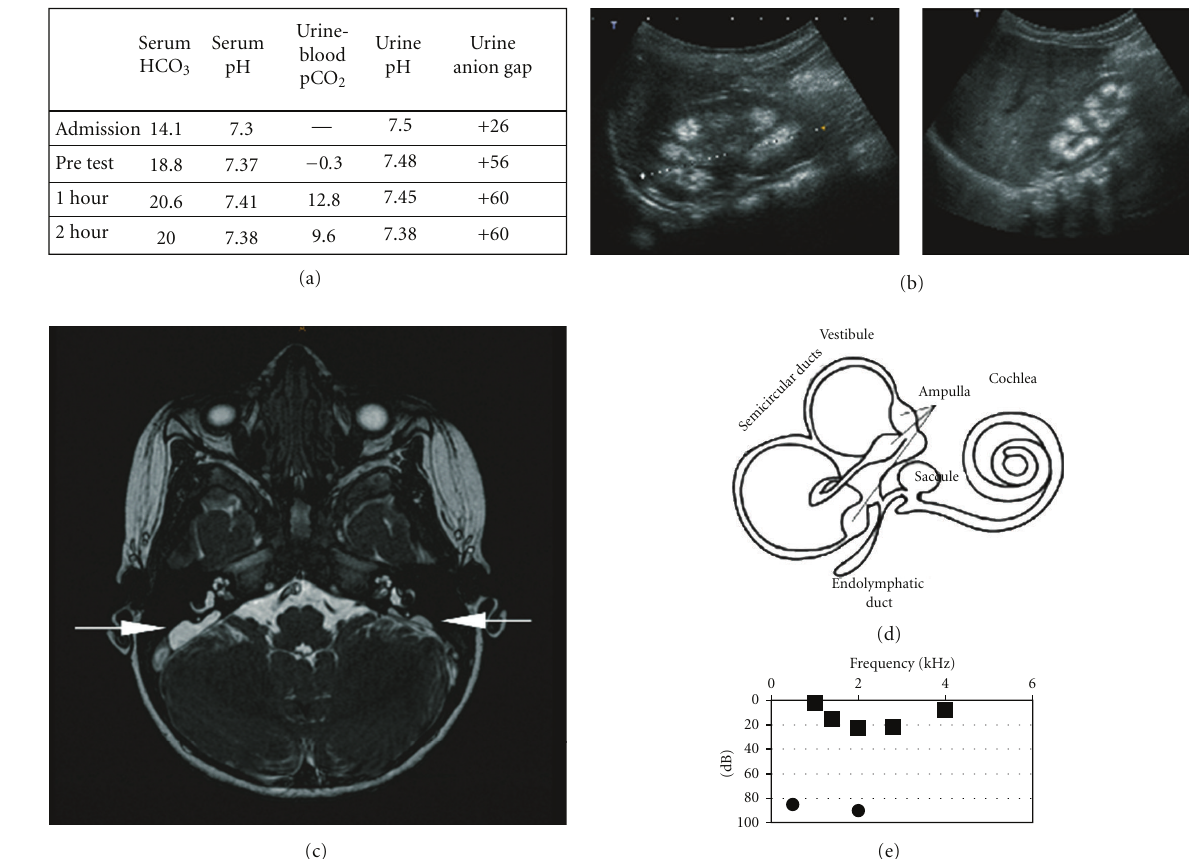
Figure 1: (a) Results of bicarbonate loading test with 1 mmol/kg NaHCO 3 infusion. (b) Ultrasound of the left and right kidney with evidence of nephrocalcinosis. (c) Axial FIESTA cerebral MRI: bilateral enlargement of the endolymphatic sac (arrows), markedly larger on the right. (d) Schematic image of the inner ear. (e) Results of free field measurement and inserted right ear